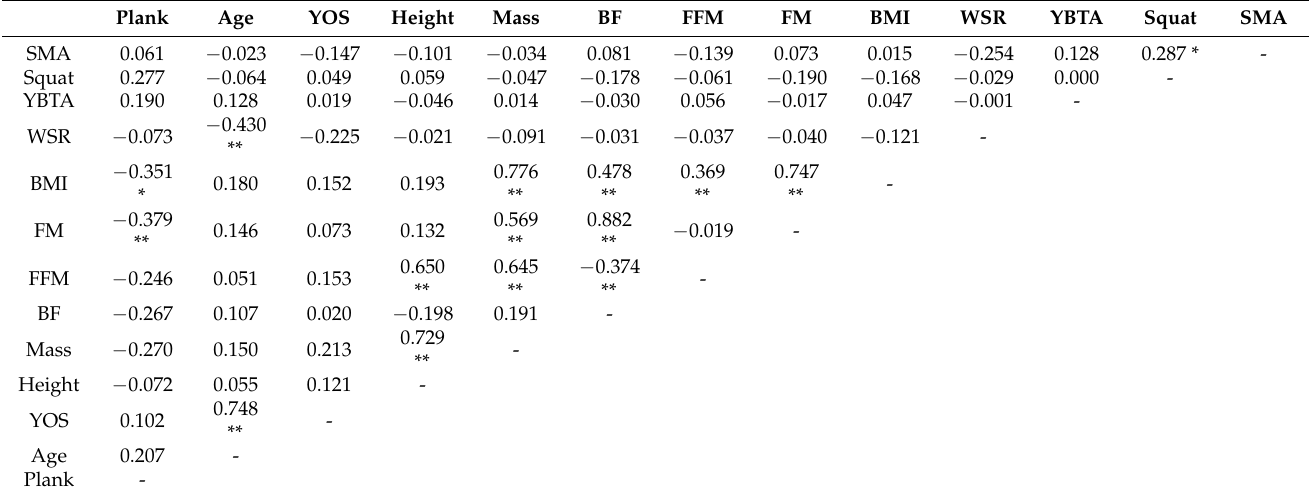
Table 2. Correlation Matrix—Demographics, Body Composition, and